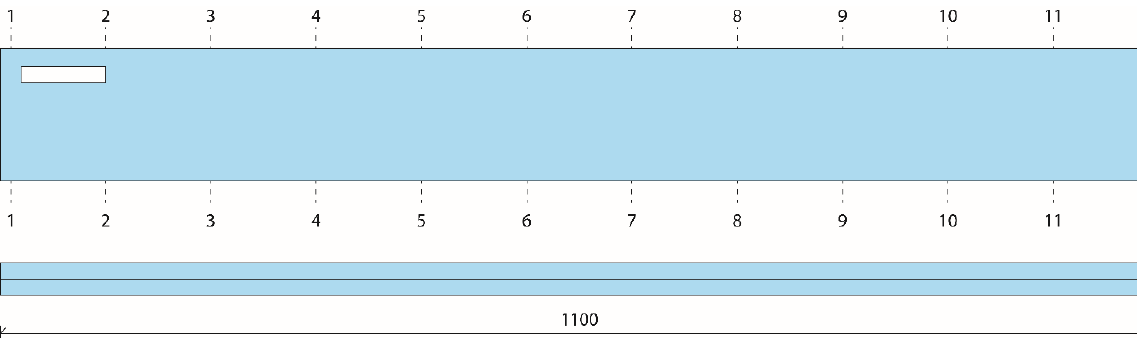
Fig. 4 Measurement of the edge offset and position of the strain gauges.